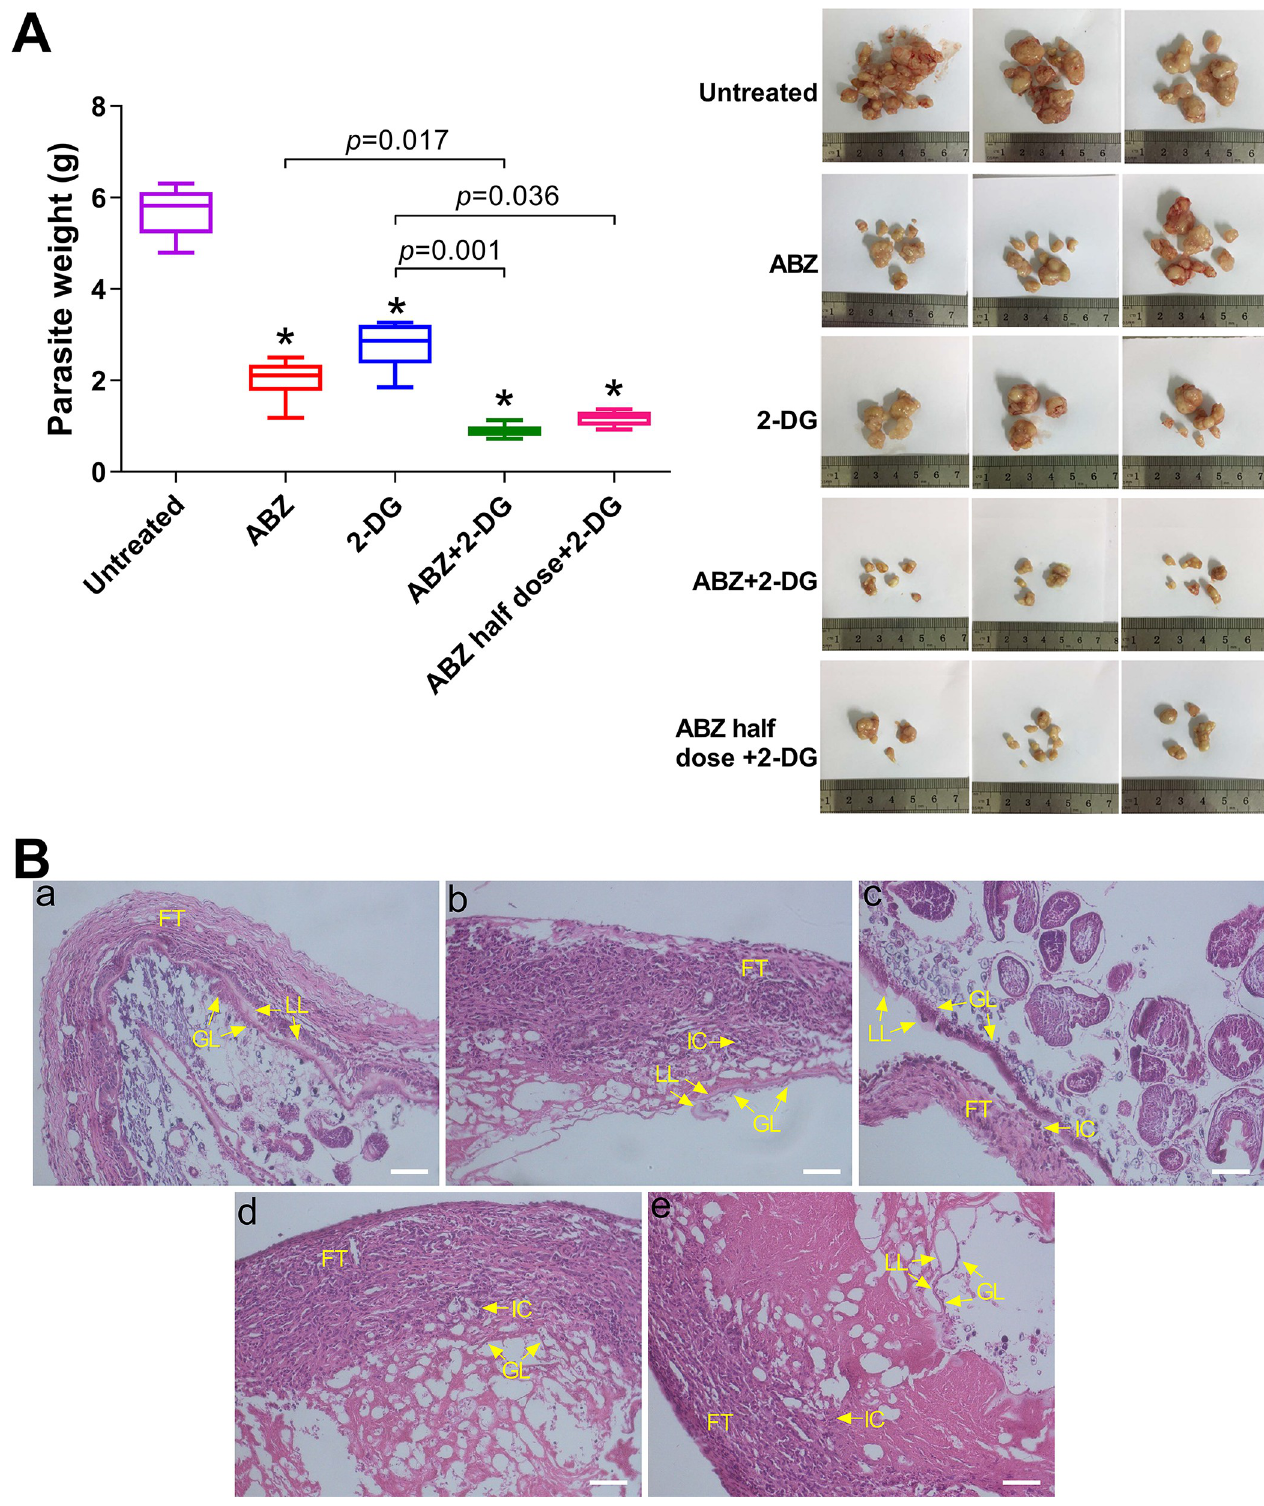
Fig 3. In vivo effect of 2-DG and its combination with ABZ in E . multilocularis –infected mice. (A) The weights and gross morphology of the metacestodes in untreated mice and mice treated with drugs for 6 weeks. � p < 0.05 vs. untreated mice. (B) Histopathological examination of E . multilocularis metacestodes from different treatment groups. a, mice infected with E . multilocularis ; b, c, d, and e, infected mice treated with ABZ (200 mg/kg/day), 2-DG (500 mg/kg/day),